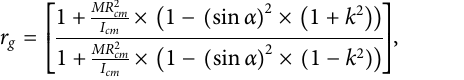
Frontiers in Built Environment |